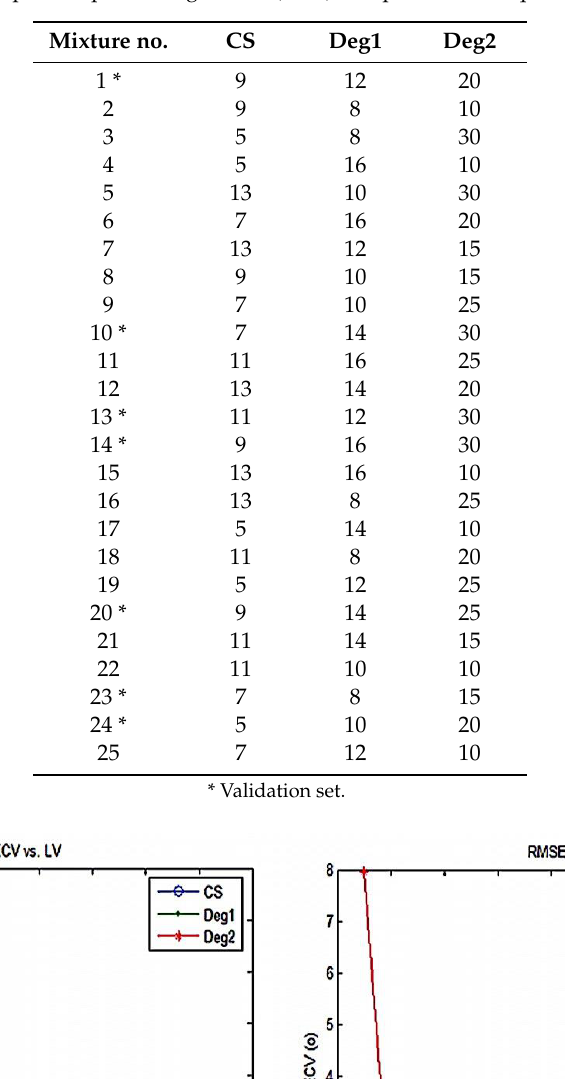
Table 3. Concentrations of different mixtures of CS, Deg1 and Deg2 used in the calibration and validation sets in principal component regression (PCR) and partial least square (PLS-2) methods.